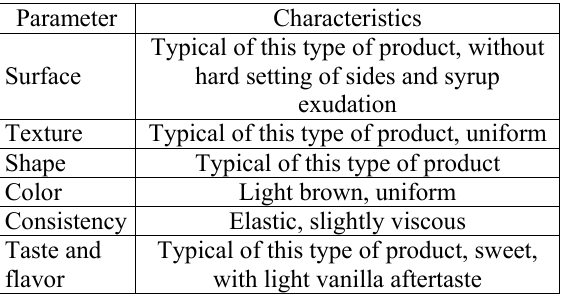
Table 8. Physicochemical parameters of bar with anti-